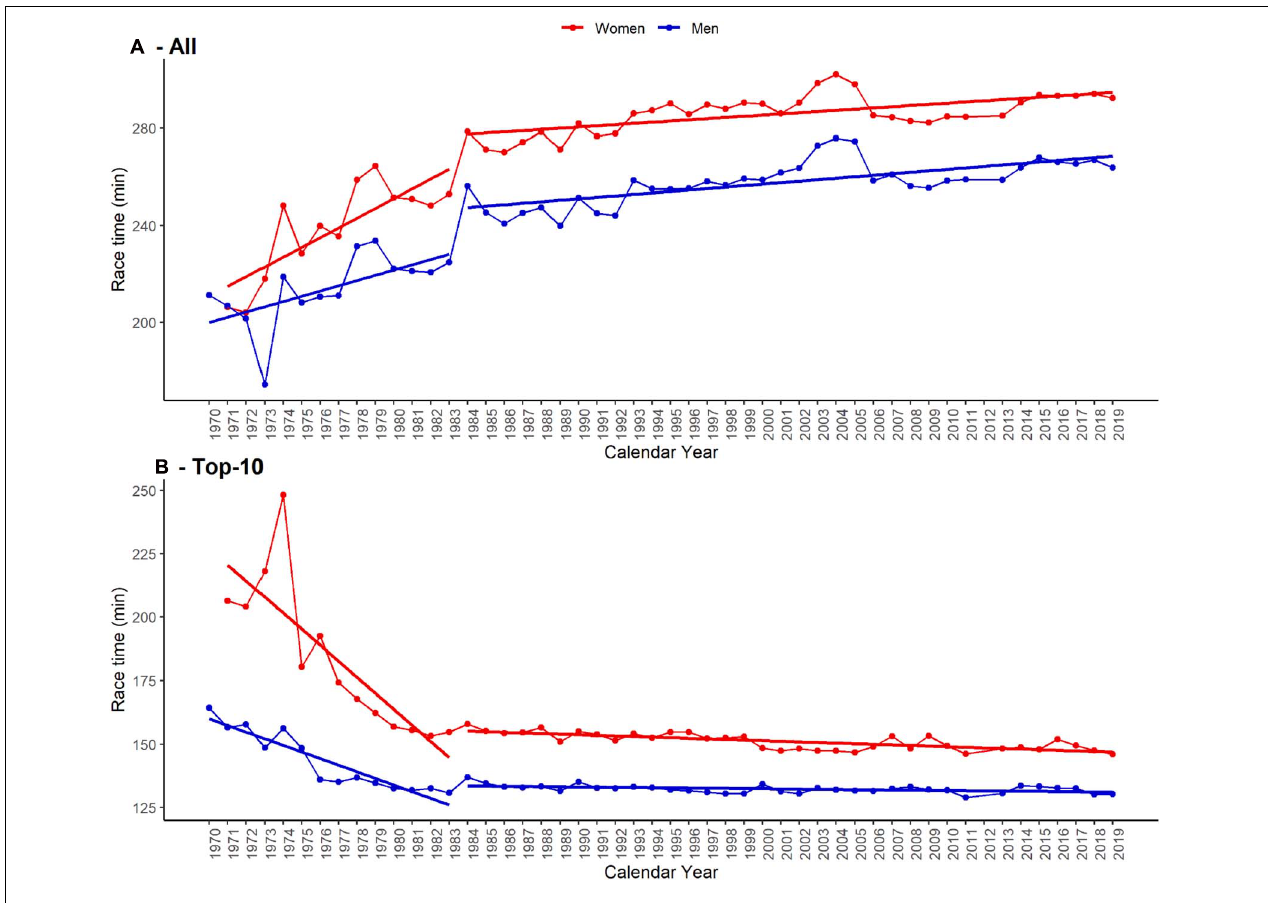
FIGURE 2 | Race time across years for all finishers (A) and top-ten finishers (B) .